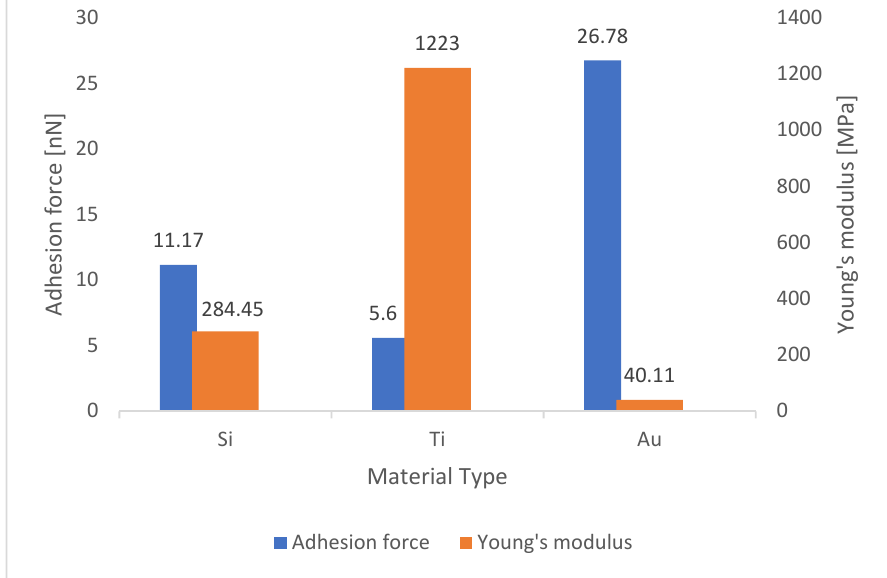
Figure 6. Comparison of values of Young’s modulus with adhesion force in the silver surface.